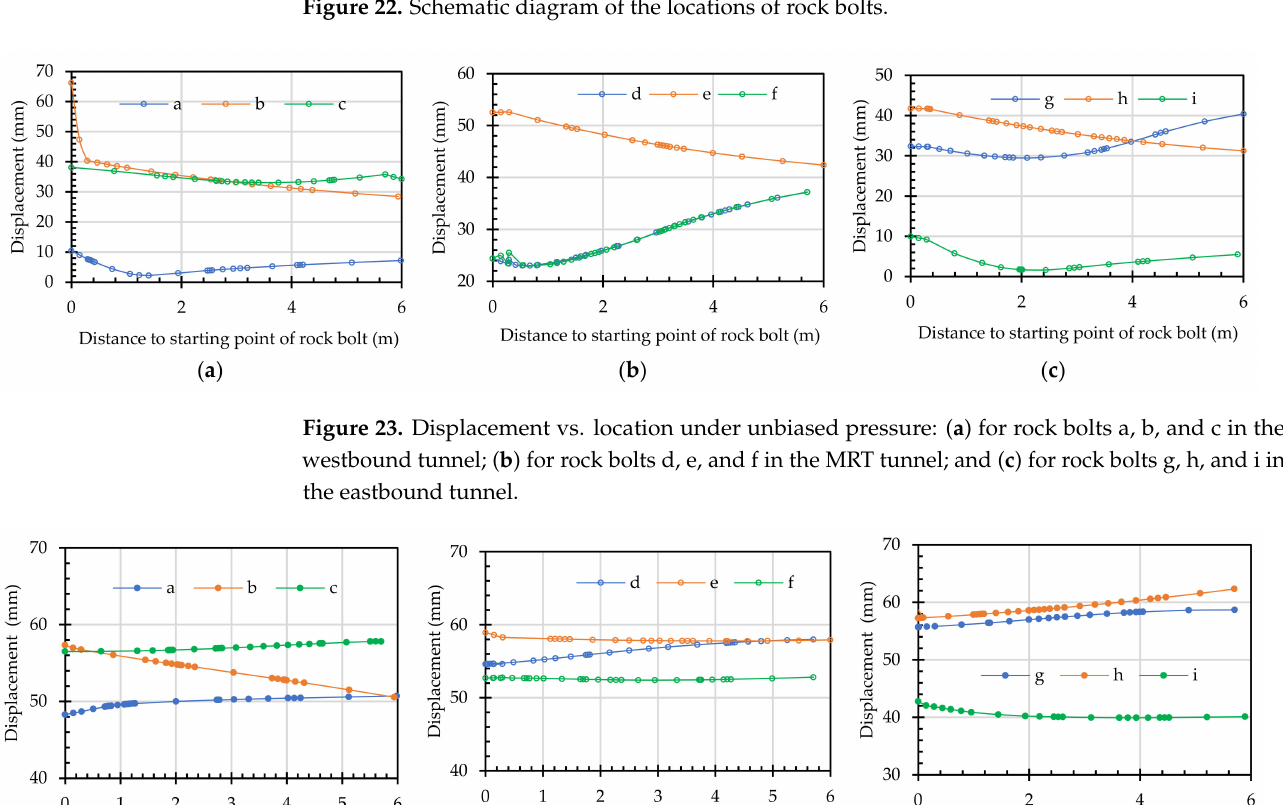
Figure 24. Displacement vs. location under biased pressure: ( a ) for rock bolts a, b, and c in the westbound tunnel; ( b ) for rock bolts d, e, and f in the MRT tunnel; and ( c ) for rock bolts g, h, and i in the eastbound tunnel.